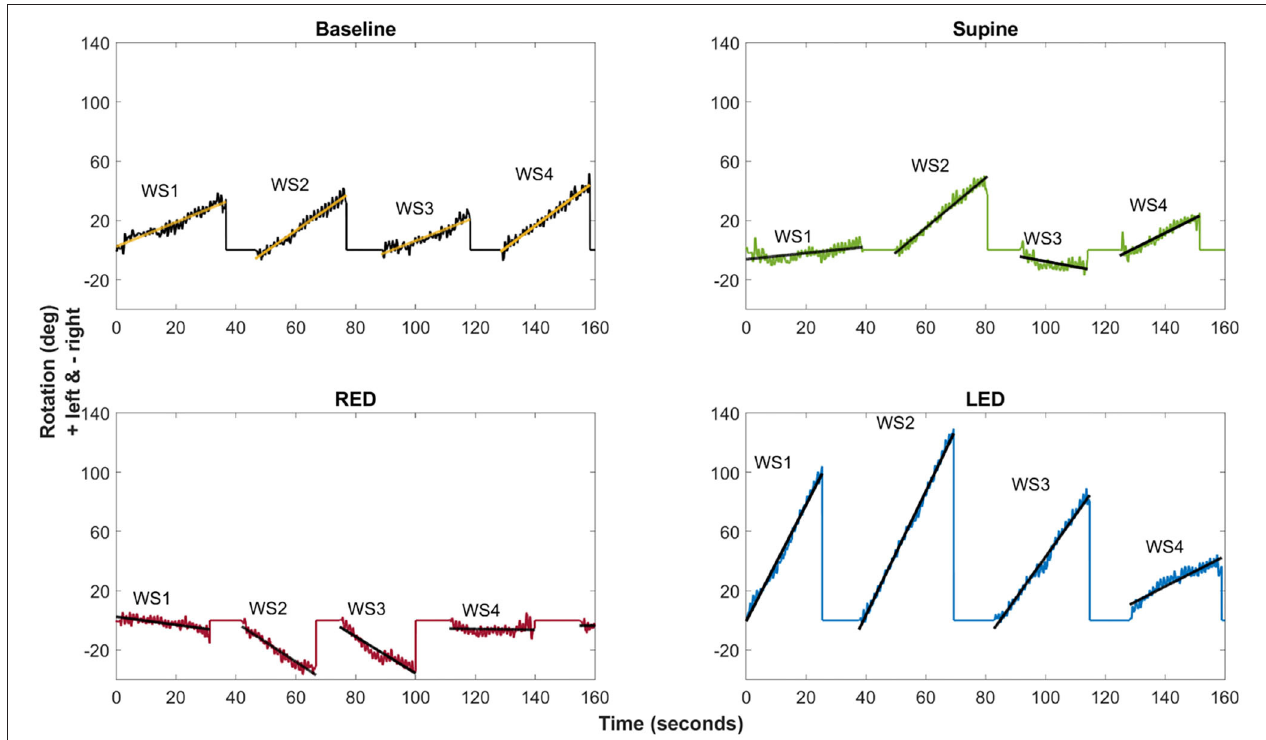
FIGURE 5 | The example of the chest heading orientation (yaw) with linear regression lines for all four resting positions of a single subject (#25). The oscillations in the yaw result from upper body twists while walking. Linear regression of the yaw was computed for each WS (WS1–WS4) separately. The slope of the fitted linear regression lines (“yaw slope”) was used in statistical investigations as an estimate of heading direction. Upper left: Baseline trial showing tendency to walk to the left side. Upper right: deviation decrease to the left side during the supine trial. Bottom left: Turn to the right-hand side during RED trials. Bottom right: Turn to the left-hand side during LED